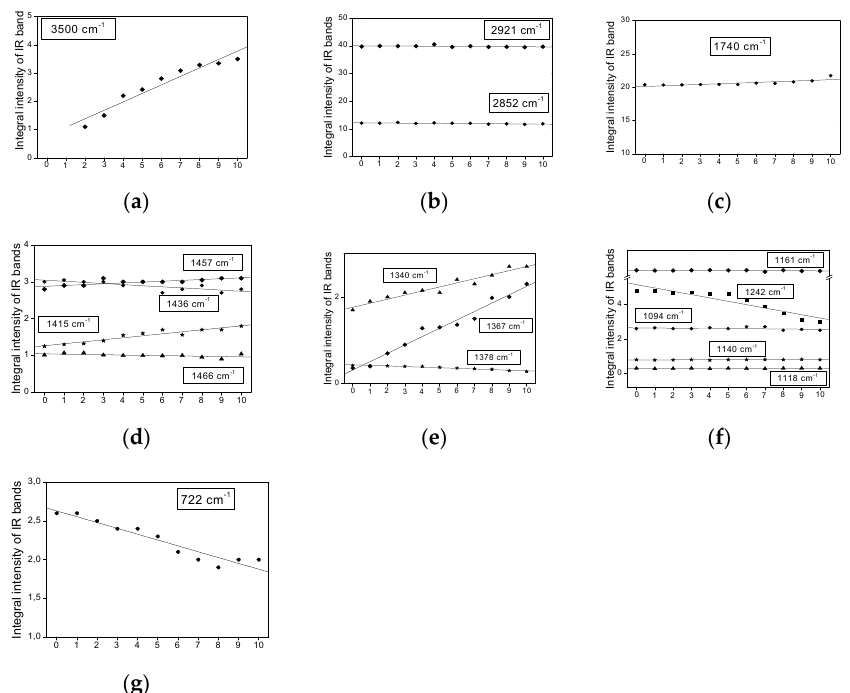
Figure 6. The dependence of the band intensity on heating time, as observed in the IR spectra of the rapeseed oil at: ( a ) 3500, ( b ) 2921 and 2852, ( c ) 1740, ( d ) 1466, 1457, 1436 and 1415, ( e ) 1378, 1367 and 1340, ( f ) 1242, 1161, 1140, 1118 and 1094, and ( g ) 722 cm − 1 . All the relationships presented in Figures 3–6, from the statistical point of view, should be considered linear dependencies because their correlation coefficients are placed in the range of 0.800–0.970. Most of them show a similar direction of change, whether positive or negative. However, some of them exhibit a positive variation in one case and a negative one in the other. Such a situation appears for the bands at 1740, 1718, as well as 1457, 1436, and 1357 cm − 1 , observed mainly for the coconut and rapeseed (canola) oils. They correspond to the following vibrations: ν (C=O), δ as (CH 3 ) + δ as (CH 2 ), ρ (=CH) and δ s (CH 3 ) [29]. This effect probably originates from the fact that these oils are characterized by low smoke points (177 °C for coconut and 107 °C for rapeseed (canola)) and their decomposition appears at a lower temperature than those in the other studied oils. Three types of thermal dependencies are observed for the bands in the IR spectra of the studied oil samples: • The bands do not change their position and intensity during the periodical heating of the oils. Such behavior is typical for the majority of the studied oils. This behavior is observed for the bands corresponding to the vibrations of the CH 3 and CH 2 groups, i.e., ν as (CH 3 /CH 2 )—2981; ν s (CH 3 /CH 2 )—2852 (Figures 3b, 4b, 5b and 6b); δ as (CH 3 /CH 2 )— 1466, 1457, 1436, 1415 (Figures 3d, 4d, 5d and 6d) and δ s (CH 3 /CH 2 )—1378, 1367, 1340 (Figures 3e, 4e, 5e and 6e). The methyl and methylene groups are the most stable fragments of the triacyl- and diacyl-glycerol molecules. • The bands show an increase in their intensity with increasing heating-time of the oils.